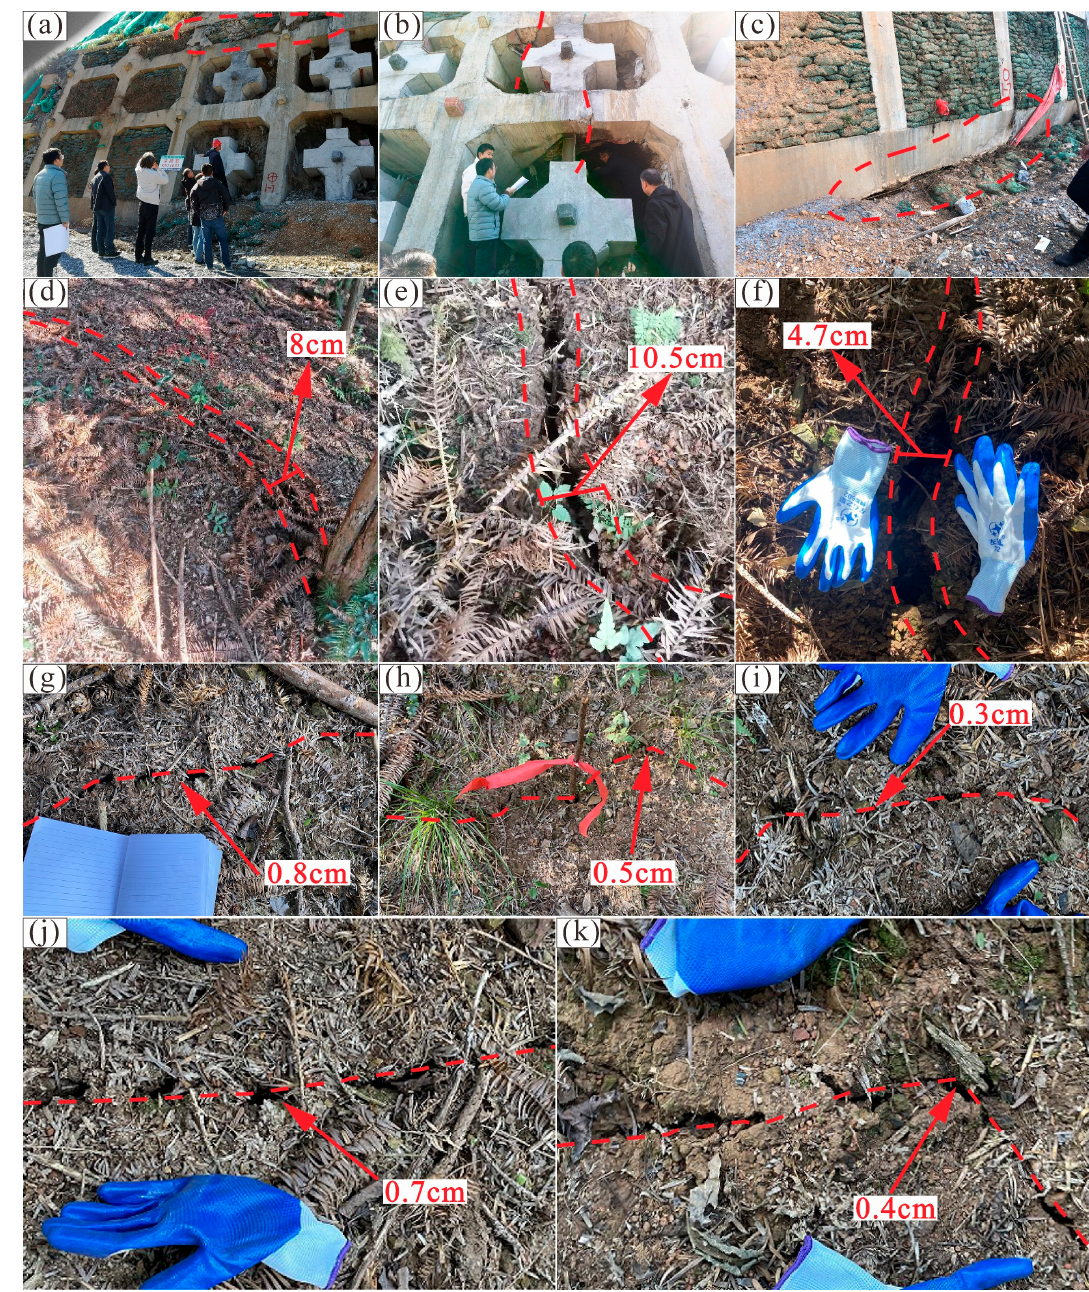
Figure 5. Photos of the Anling landslide deformation at stage 6. ( a ) Failure of lattice beam at the head of the 5th-grade slope. ( b ) Crack of lattice beam at the middle of the 5th-grade slope. ( c ) Deformation of slope protection at the toe of the 5th-grade slope. ( d ) Width of Crack1. ( e ) Width of Crack2. ( f ) Width of Crack3. ( g ) Width of Crack4. ( h ) Width of Crack5. ( i ) Width of Crack6. ( j ) Width of Crack7. ( k ) Width of Crack8.